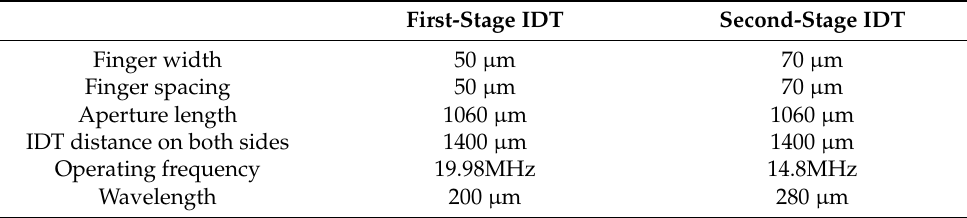
Table 3. Design parameters for the multi-stage electrodes.